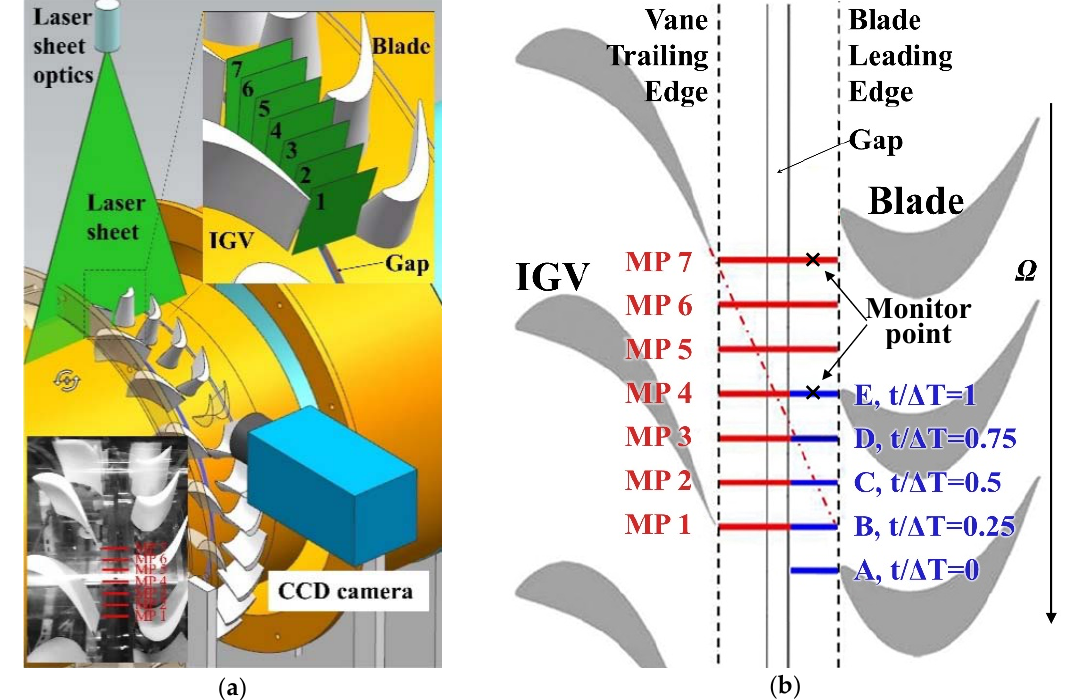
Figure 3. Layout of the measurement (a) and measurement planes (MPs) and positions employed for the measurement (b).